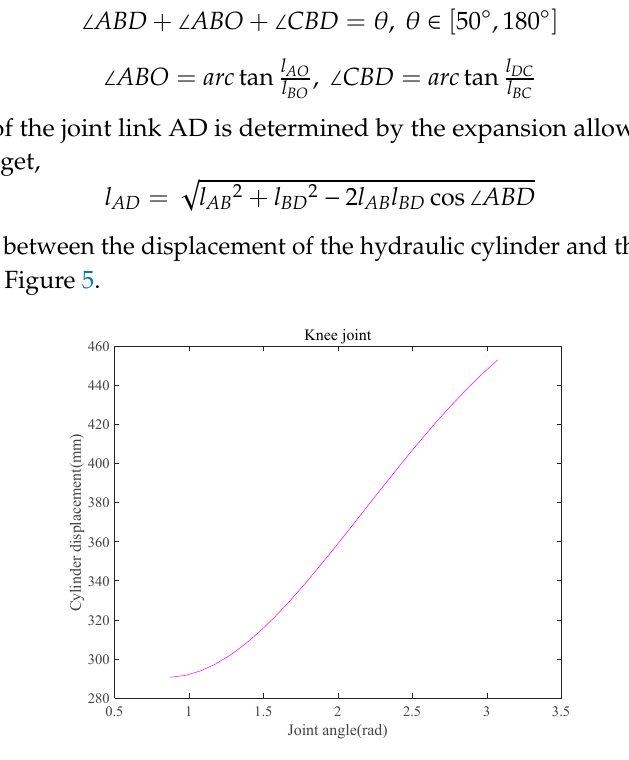
Figure 4. Schematic diagram of a four-bar linkage.